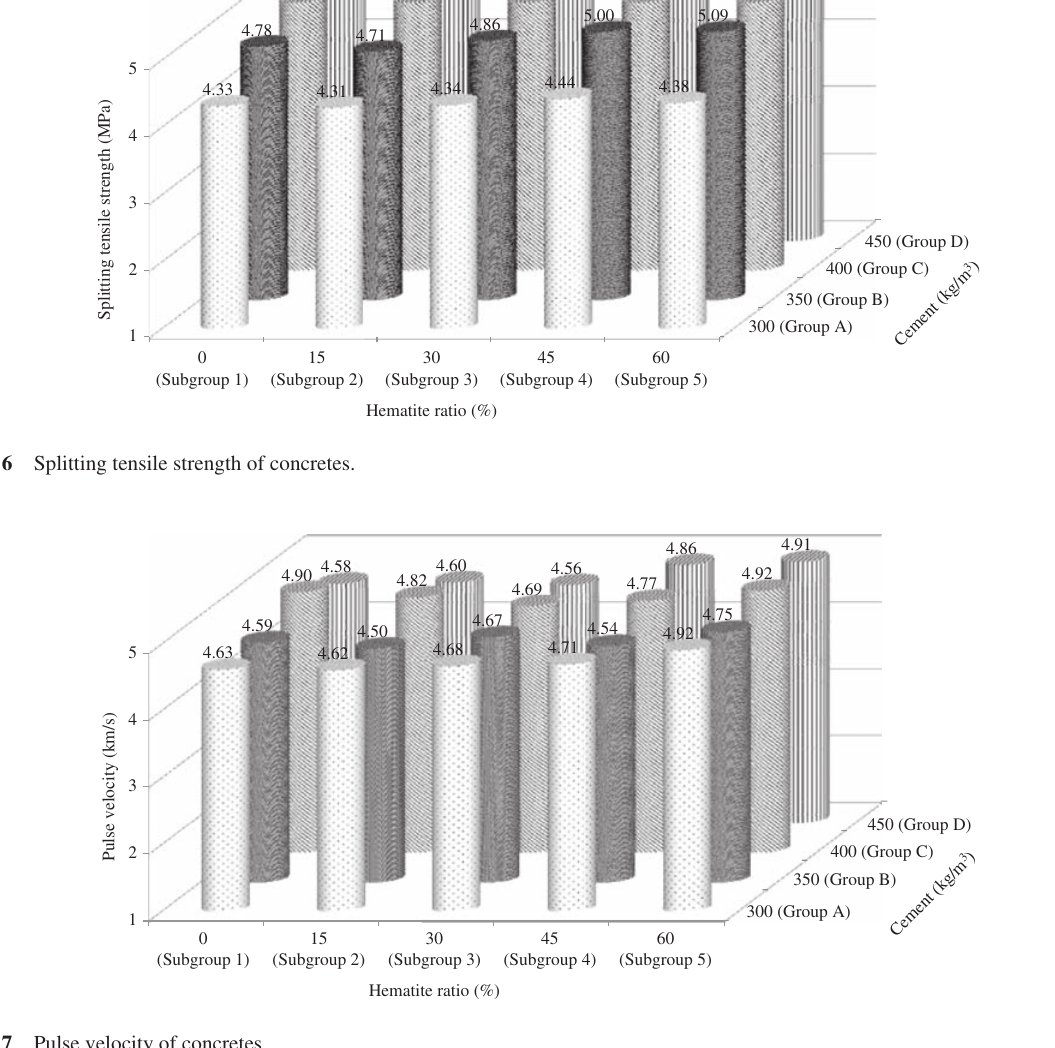
Figure 7 Pulse velocity of